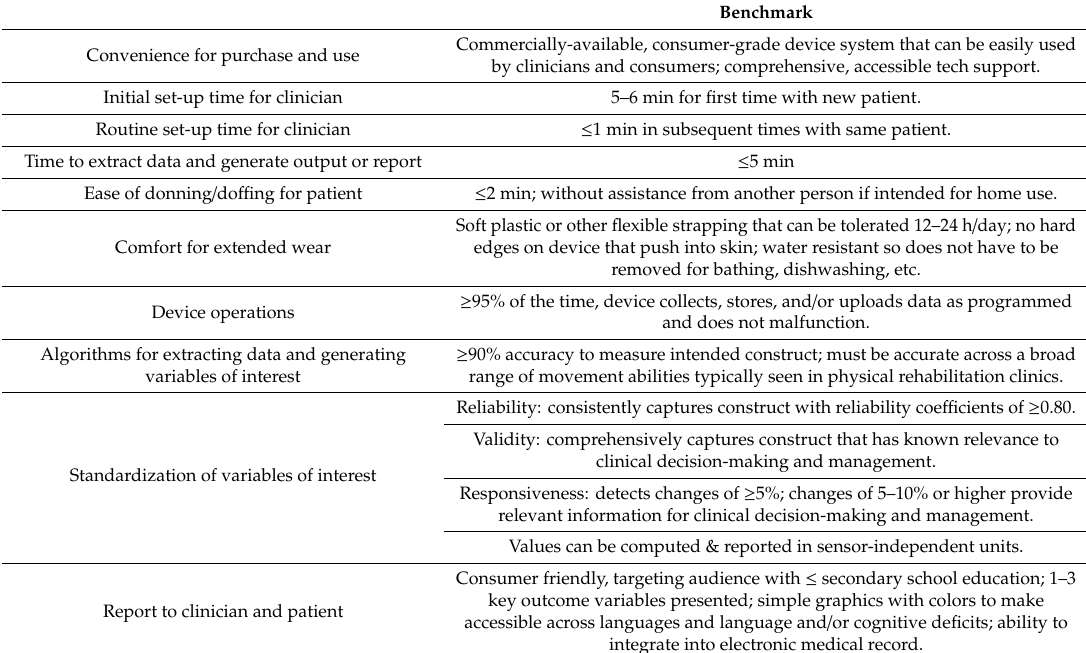
Table 2. Benchmarks for wearable device systems that will facilitate implementation into routine physical rehabilitation clinical